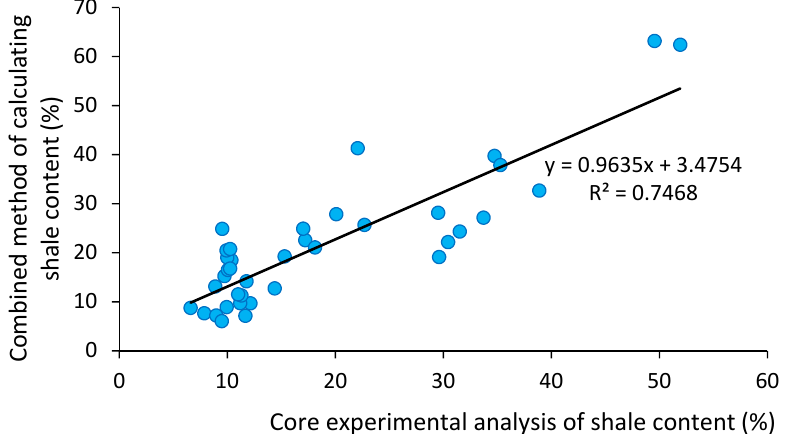
Figure 14. Cross diagram of shale content in core experiment analysis and shale content calculated by combination method.